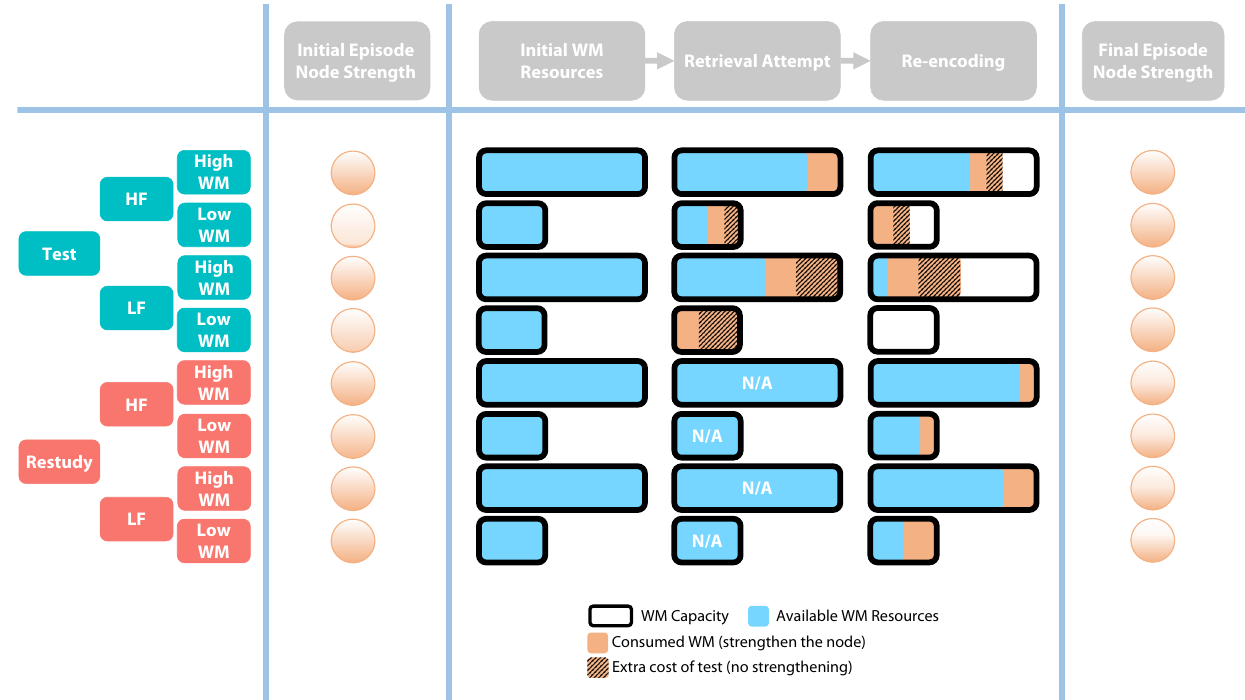
Fig. 3 Schematic diagram illustrating how the modi fi ed SAC model predicts the outcome of each condition in the current experiment. We assume that both the retrieval attempt and post-retrieval re-encoding processes consume WM resources (brown and brown with diagonal lines) from a limited WM pool (i.e., WM capacity (black frame)), resulting in left WM resources (blue) for future use. The post-retrieval re-encoding process only strengthens the nodes when retrieval attempts are successful because no feedback is provided. The consumption of WM negatively correlates with the Fribble frequency (HF for high frequency, LF for low frequency) and is used to strengthen the episode node, as depicted in the fi nal column. When the available WM resources (blue) are not suf fi cient for both processes (i.e., participants with lower WM capacity learning LF associations), the associations cannot bene fi t from the post-retrieval re-encoding process, thus limiting the overall testing effect.